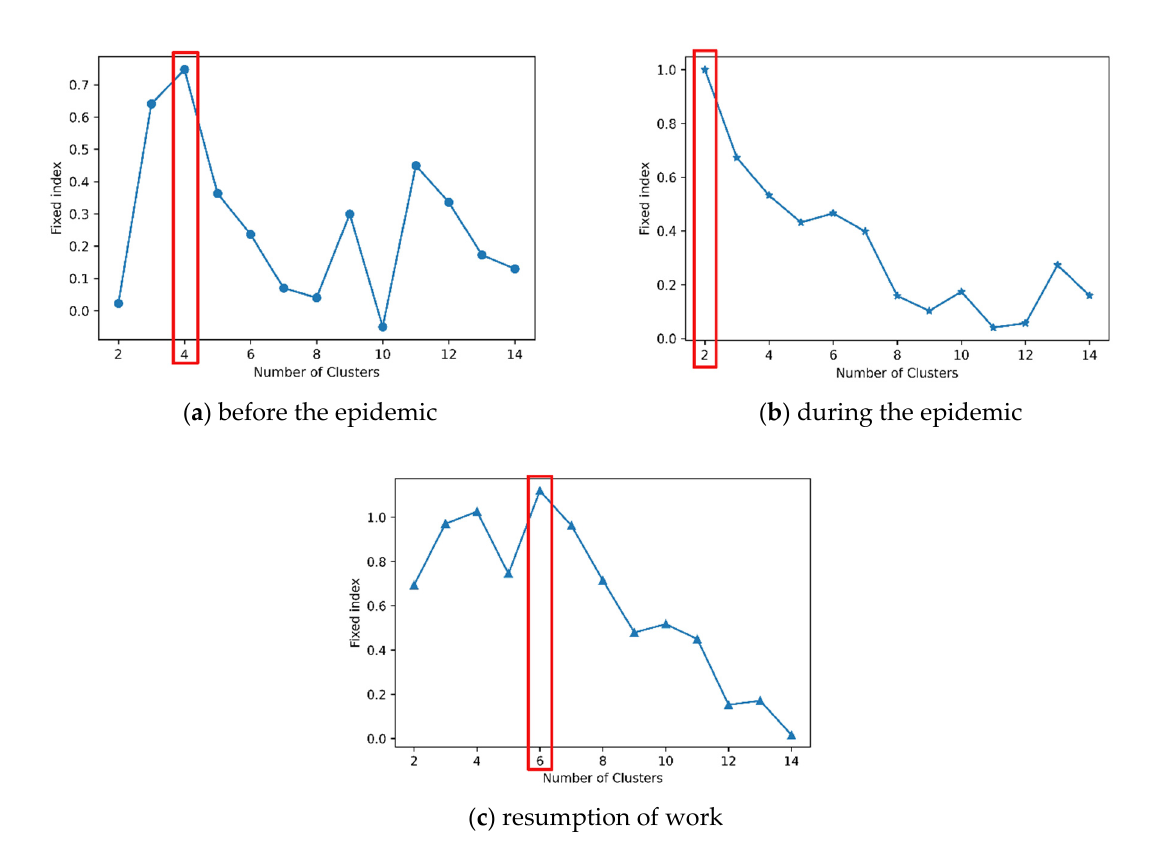
Figure 7. Relationship between the Fixed Clustering Index and K values at different stages of the epidemic.